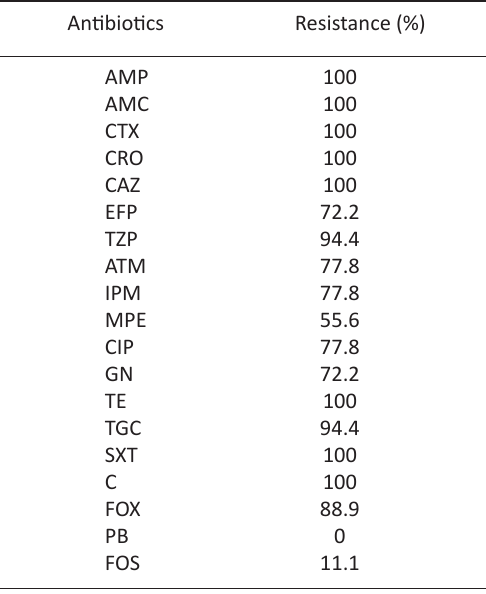
Table 1. Antibiogram of the isolated P. aeruginosa